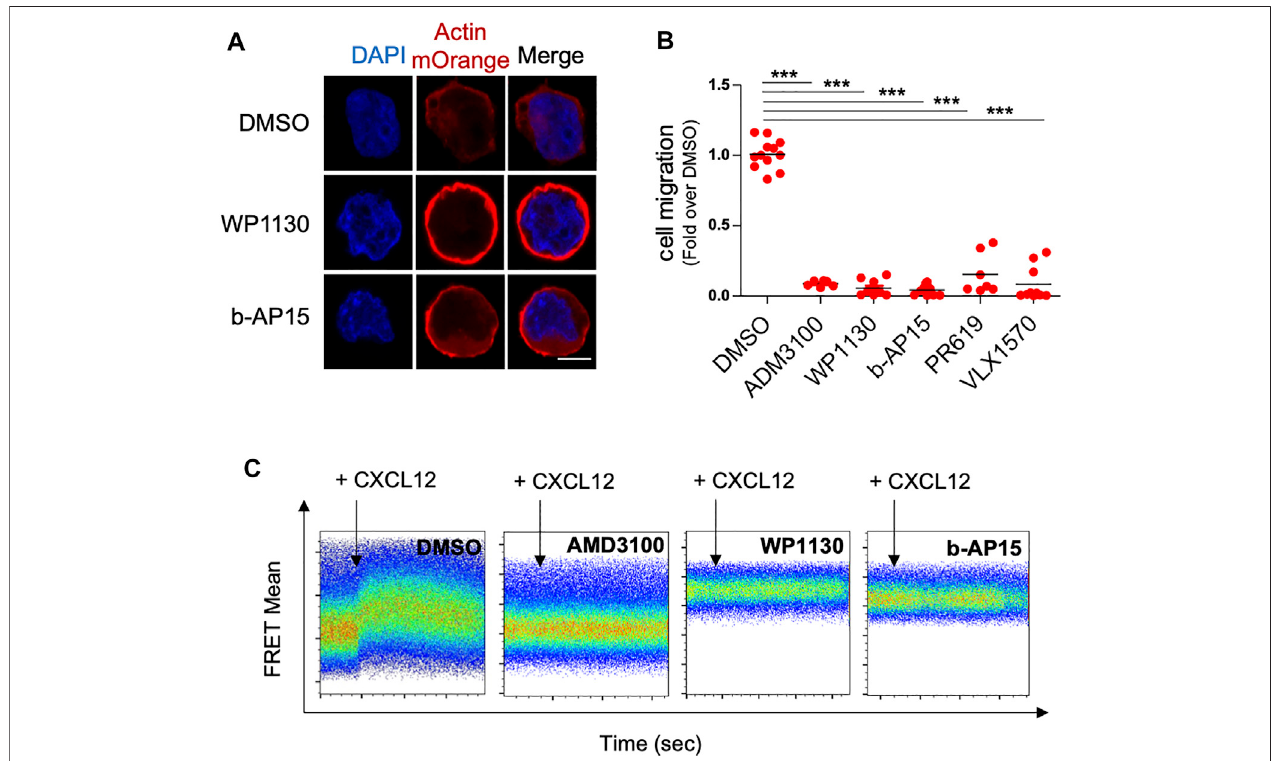
FIGURE 2 | DUB inhibition increases actin polymerization and blocks leukemic cell chemotactic migration. (A) Confocal microscopy analysis of actin-mOrange distribution inACT Jurkat cells treated withDMSO or15 µM ofWP1130 and b-AP15for 30 min. Nuclei were counterstained withDAPI before analysis. Scalebar, 5 µm. (B) Effects of WP1130, b-AP15, PR-619 and VLX1570 on CXCL12-induced Jurkat T cell migration. Cells were migrated against 100 ng/ml of CXCL12 for 90 min in the presence ornot of15 µM oftheindicated compound. Results areexpressed asthefold ofcellmigration compared toDMSO controlcondition. Scatter plotsshow the mean of n (cid:2) 3 independent experiments. *** p < 0.001, unpaired t -tests between DMSO and each treated condition. (C) Real time analysis of actin FRET signals induced by 100 ng/ml CXCL12 on ACT cell line treated with DMSO or 15 µM WP1130 and b-AP15 for 30 min. Flow cytometry histograms show representative data on ACT cell line treated with DMSO or DUBs inhibitors. Data are representative of n (cid:2) 3 independent experiments. The effect of CXCR4 inhibitor AMD3100 (5 µM) on CXCL12-induced actin FRET signals is shown as